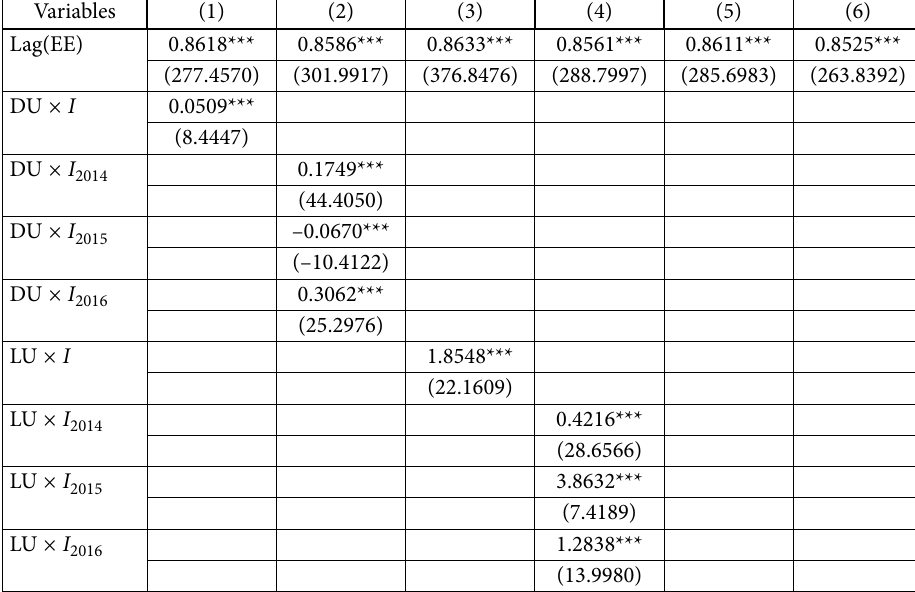
Table 6. Estimation results of quasi-DID